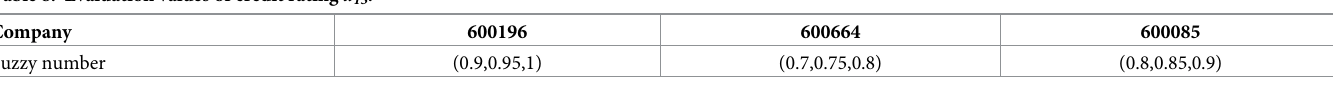
Table 8. Evaluation values of credit rating a 15 .